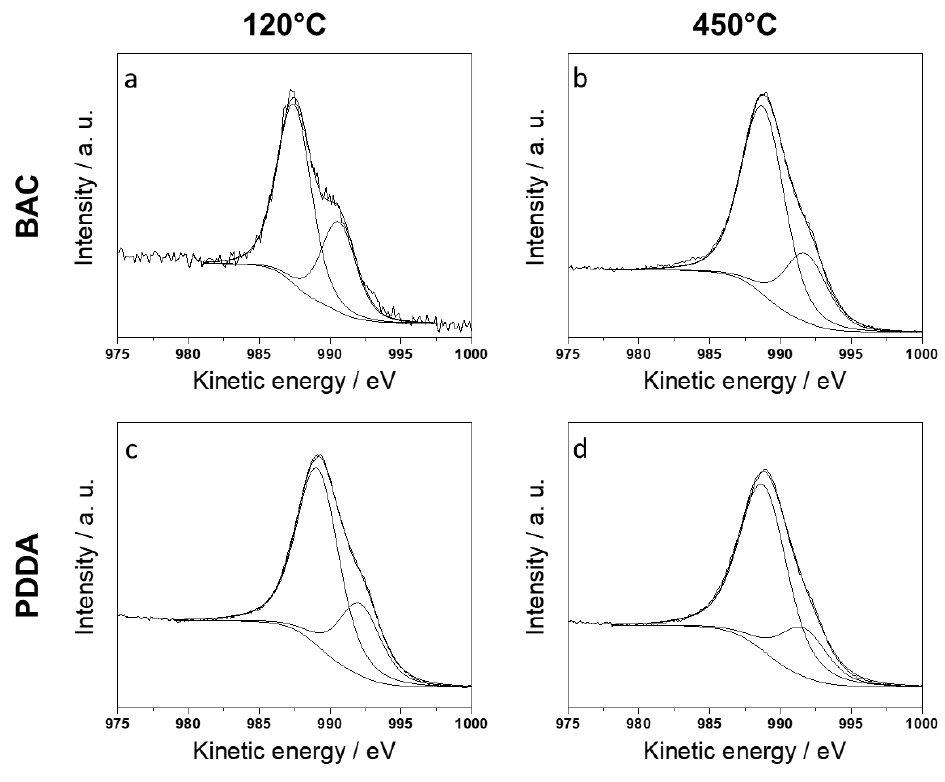
Figure 5. ZnL 3 M 4,5 M 4,5 XP spectra of dried (120 ◦ C) and calcined (450 ◦ C) samples. ZnO-BAC ( a , b ); ZnO-PDDA ( c , d ). Table 2. Zn2p, ZnL 3 M 4,5 M 4,5 positions, and corresponding modified Auger parameter (α′) for all of the samples, as a function of the stabilizer and of the thermal treatment.